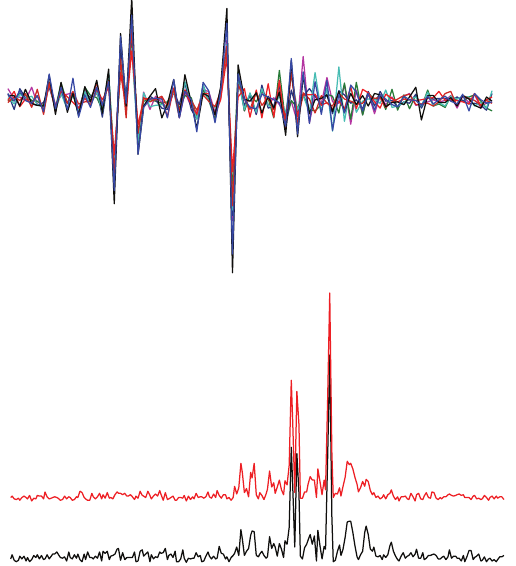
Figure 3: Examples of the combination of in vivo signals from a multichannel coil array. Upper: phase alignment displays the real parts of the spectra without phase correction. Lower: a combined spectrum (red) and a channel spectrum with the highest SNR, shown in absolute mode. The SNRs of the combined spectrum and the channel spectrum with the highest SNR were 77.8 and 46.1, respectively.